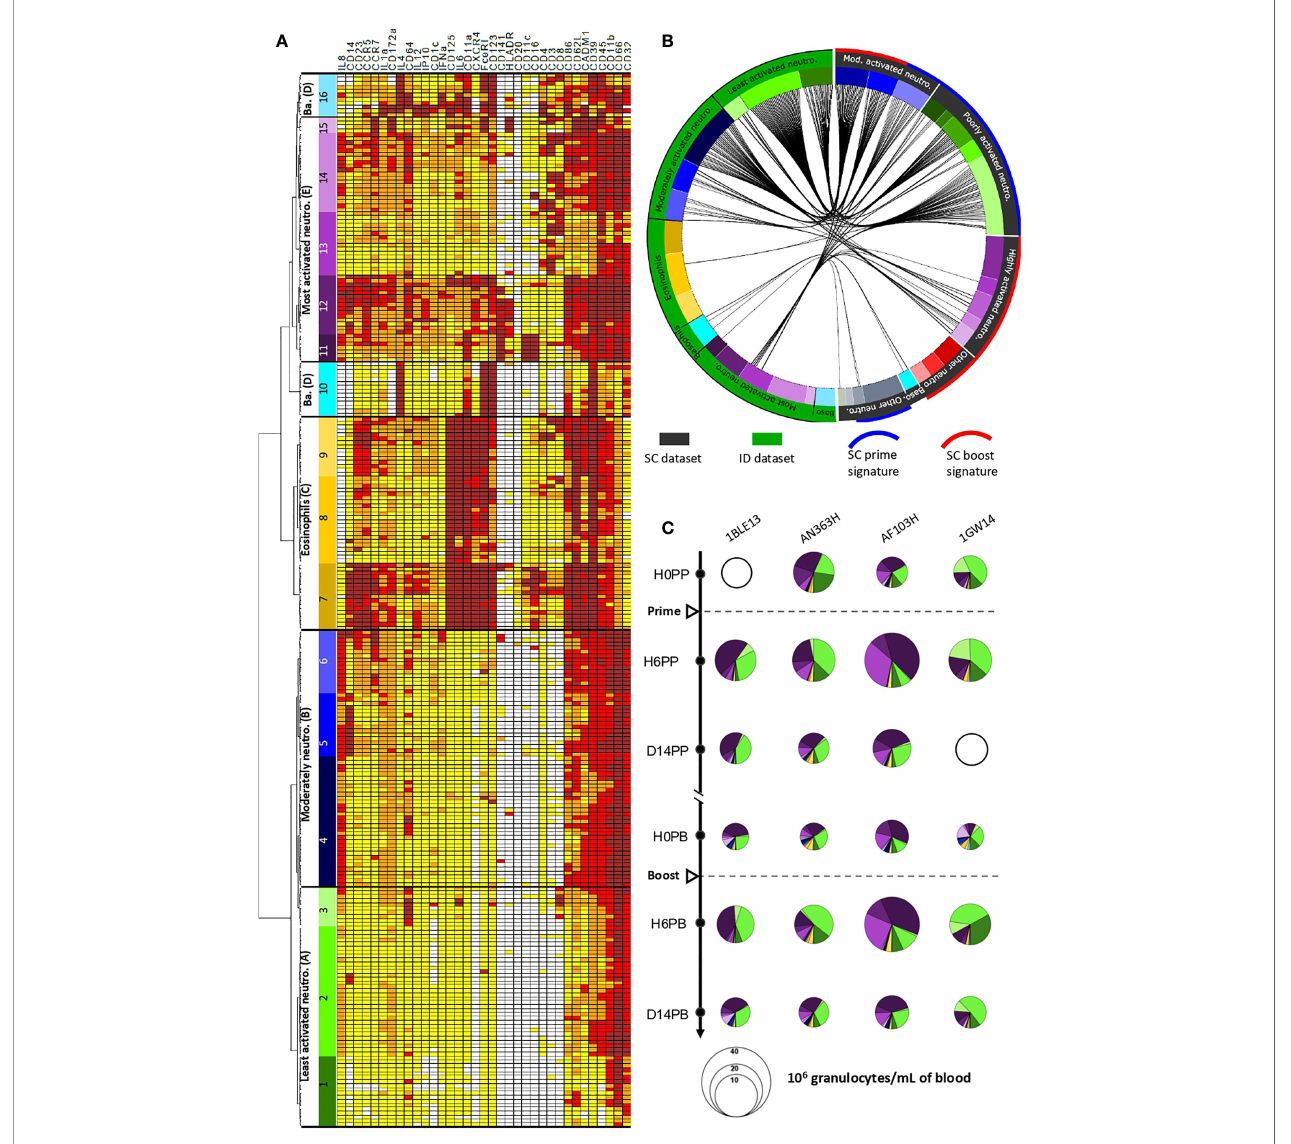
FIGURE 5 | Phenotypic diversity and dynamics in granulocytes after ID and SC MVA immunizations. (A) Hierarchical clustering of granulocyte clusters from the whole ID dataset ( i.e. all animals and all timepoints), represented as a heatmap. Each row corresponds to a cell cluster and each column to a marker. The level of expression of the markers was divided into fi ve categories ranging from white to brown. The dendrogram allowed the grouping of clusters with similar phenotypes into 16 “ phenotypic families ” (numbered from 1 to 16) and “ superfamilies ” (named with letters between brackets, from A to E), colored based on the manual annotation as in (9). Neutro.: neutrophils. Ba.: basophils. (B) Comparisons of the phenotypes of granulocytes present in the ID (green) and SC (black) datasets. Black lines inside the circle connect phenotypically similar clusters after calculation of the Manhattan distance. The color code is identical to that of the heatmap. Neutro, neutrophil; Mod, moderately; Baso, basophils. (C) Pie charts representing the composition in granulocyte phenotypic families over time for each macaque after MVA immunizations by the ID route. Each slice represents a phenotypic family, for which the color is identical to that of the heatmap. The size of the pie is proportional to the cell concentration in the blood. Unavailable data are represented by empty